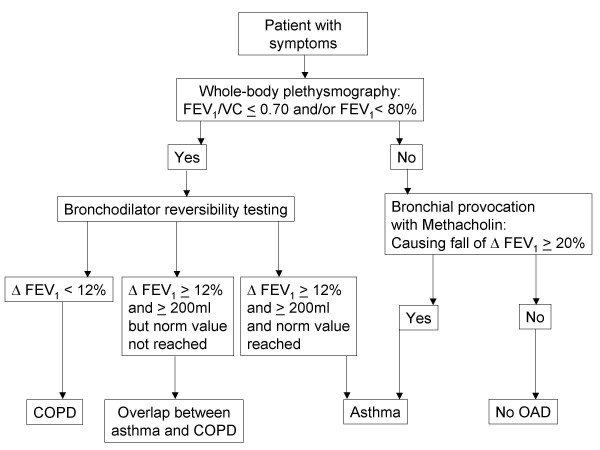
Diagnostic decision making with the reference standard (COPD = Chronic Obstructive Pulmonary Disease, OAD = obstructive airway disease).